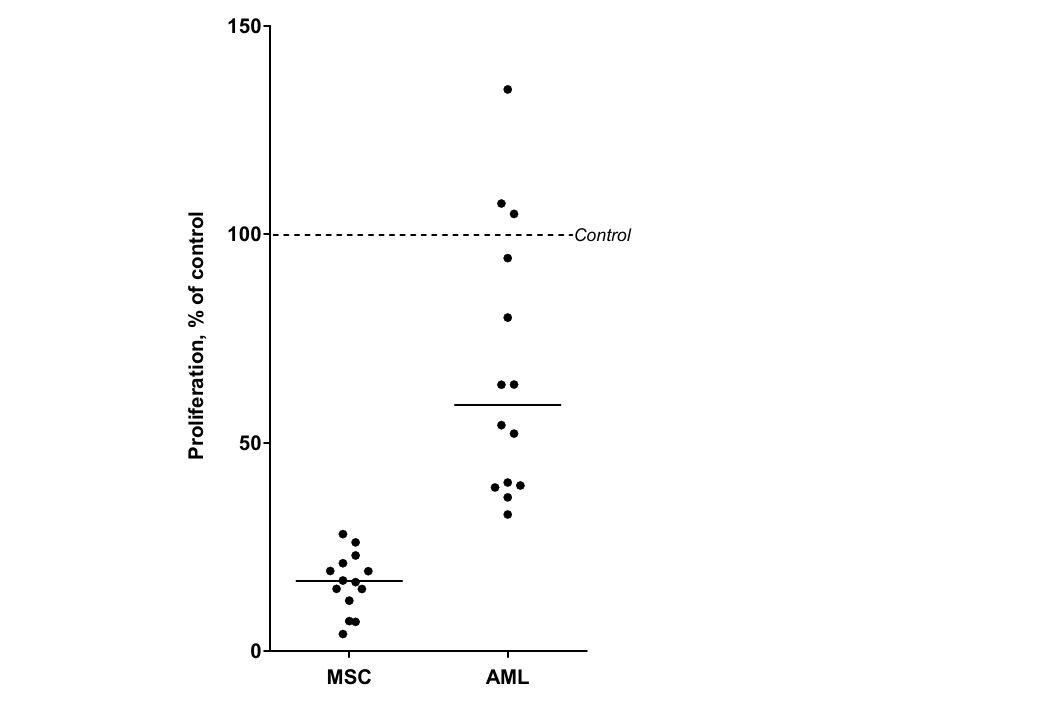
Figure 3. The effect of chloroquine (CQ) on the proliferation of primary AML cells and normal MSCs grown in coculture. The two cell populations were separated by a semipermeable membrane. Cocultures of AML cells (14 patients tested) and normal MSCs derived from a healthy donor were treated with 5 µM chloroquine for three days. Proliferation was measured using the 3H-thymidine incorporation assay for both AML cells and MSCs in cocultures, with and without chloroquine-treatment. Each dot indicates the cell proliferation of AML or MSCs after coculture, where results are shown as percent proliferation of chloroquine-treated cocultures compared to untreated cocultures, with the median level. Chloroquine inhibited the proliferation of both AML cells and MSCs in cocultures.